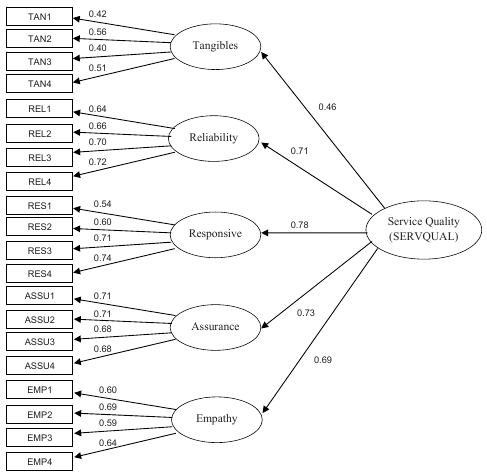
Fig. 2 – SERVQUAL deployed into SERVPERF. Source: Han, Hong, 2005.